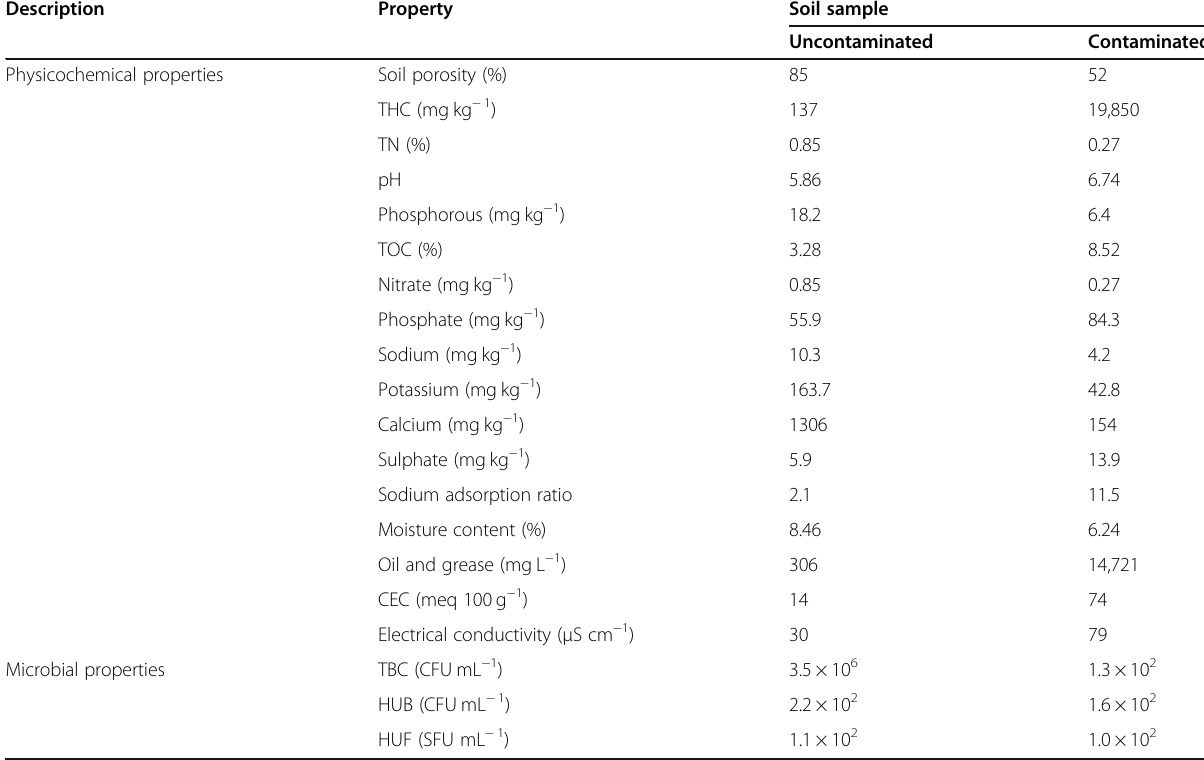
Table 2 Physicochemical and microbial properties of soil samples Description